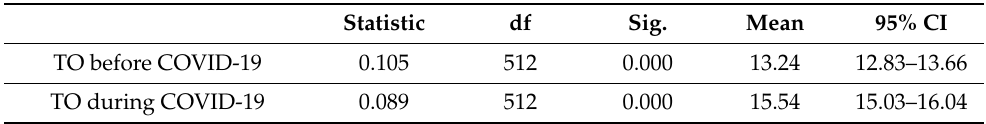
Table 2. Stress levels before and during